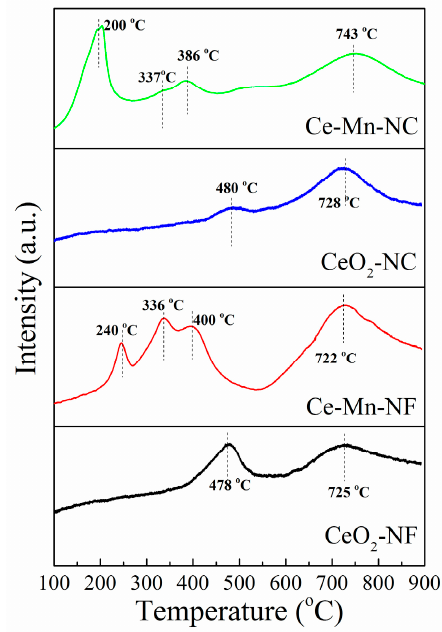
Figure 7. H 2 -TPR profiles of CeO 2 -NF, CeO 2 -NC, Ce-Mn-NF and Ce-Mn-NC.